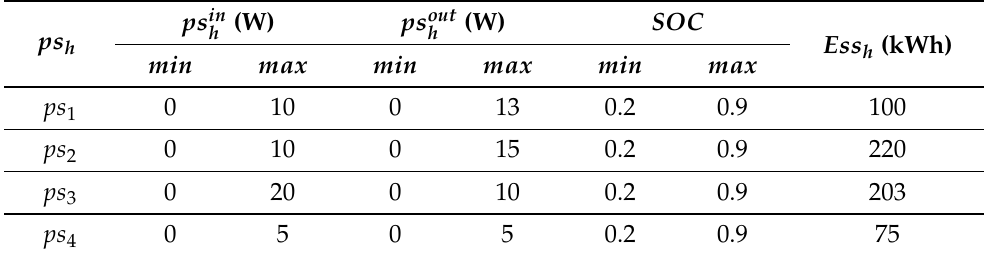
Table 1. List of power storage devices with power limitation.